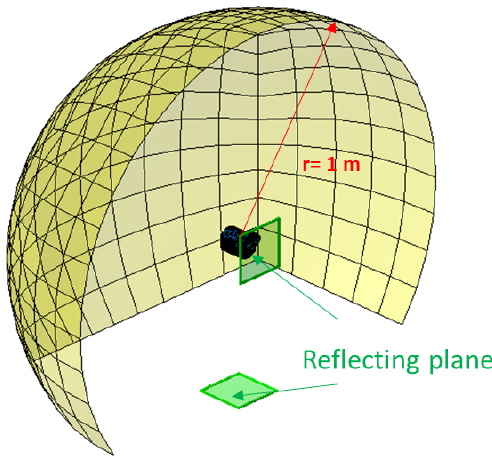
Figure 16. Field Point Mesh and reflecting planes.